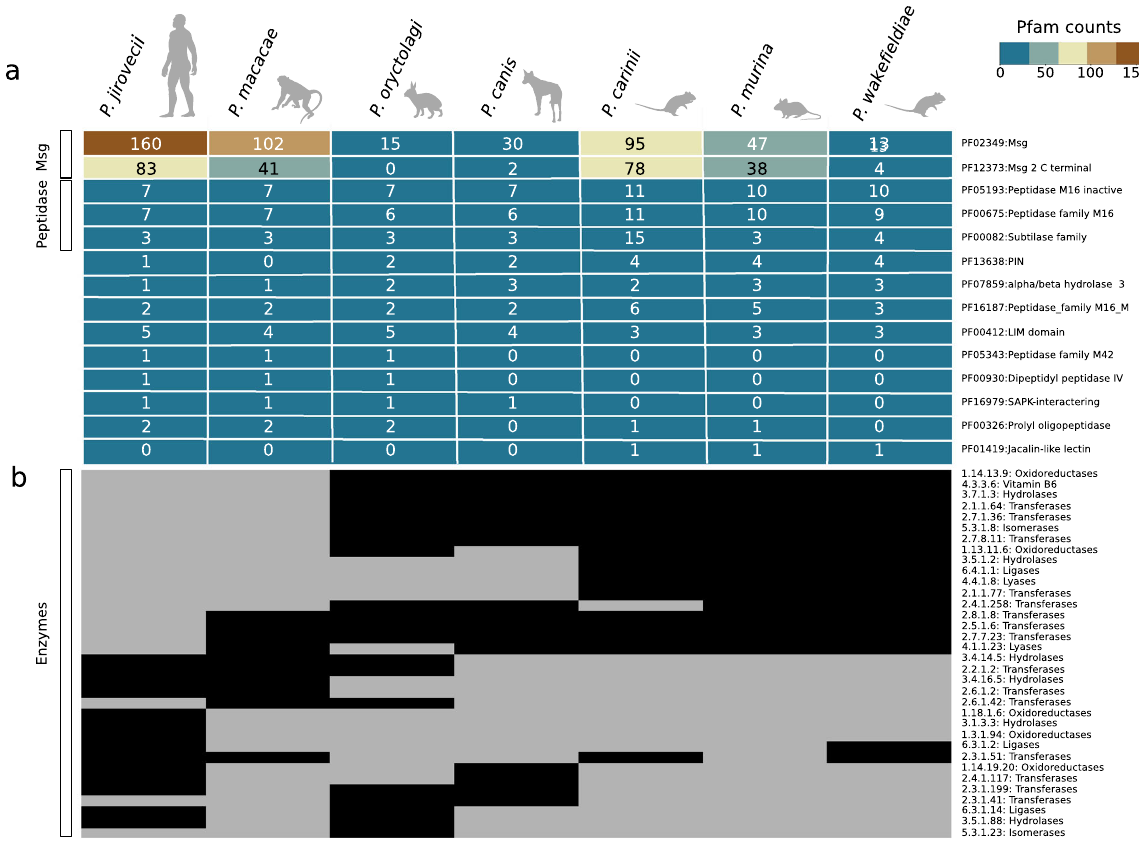
Fig. 3 Distribution of protein families among Pneumocystis species. a Heatmap of Pfam protein domains with signi fi cant differences (Wilcoxon signed- rank test, p < 0.05) are included if the domain appears at least once in the following comparisons: primate Pneumocystis ( P. jirovecii and P. macacae ) versus other Pneumocystis , clade P1 ( P. jirovecii , P. macacae , P. oryctolagi , and P. canis Ck1) versus clade P2 ( P. carinii , P. murina , and P. wake fi eldiae ), primate Pneumocystis versus clade P2. The number of proteins containing each domain is indicated within each cell for each species. The heatmap is colored according to a score, as indicated by the key at the upper right corner. b Heatmap of distribution of enzymes (represented by Enzyme Commission numbers and their KEGG functional categories), with their presence and absence indicated by black and grey colored cells, respectively. Animal icons were obtained from http://phylopic.org under creative commons licenses https://creativecommons.org/licenses/by/3.0/: mouse (Anthony Caravaggi; license CC BY-NC-SA 3.0); dog (Sam Fraser-Smith and vectorized by T. Michael Keesey; license CC BY 3.0), rabbit (by Anthony Caravaggi; license CC